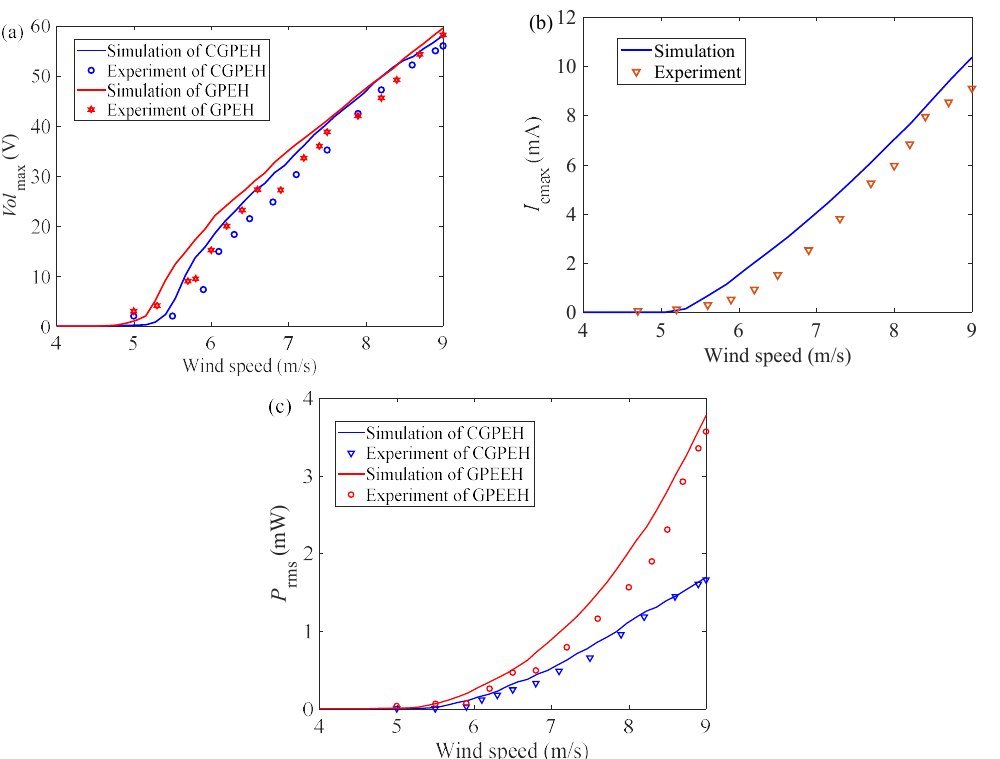
Figure 15. GPEEH and CGPEH output parameters of experimental and simulated change with wind speed ( a ) Vol max ( b ) I cmax ( c ) P rms.